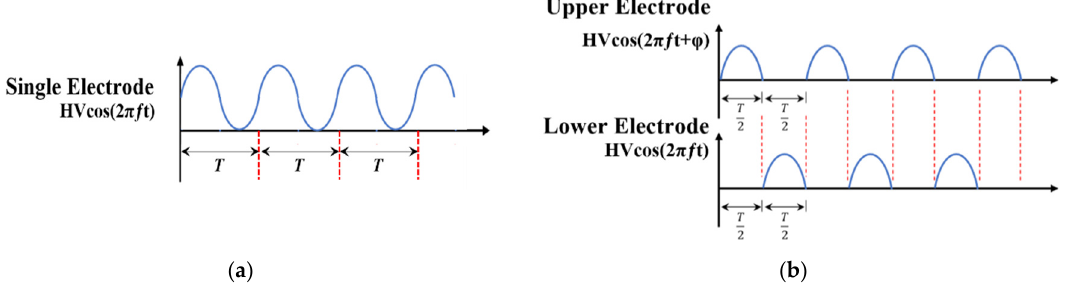
Figure 6. Input signals used in the experimental setup: ( a ) single-electrode ERA offset sine input; ( b ) dual-electrode ERA upper and lower electrode inputs.